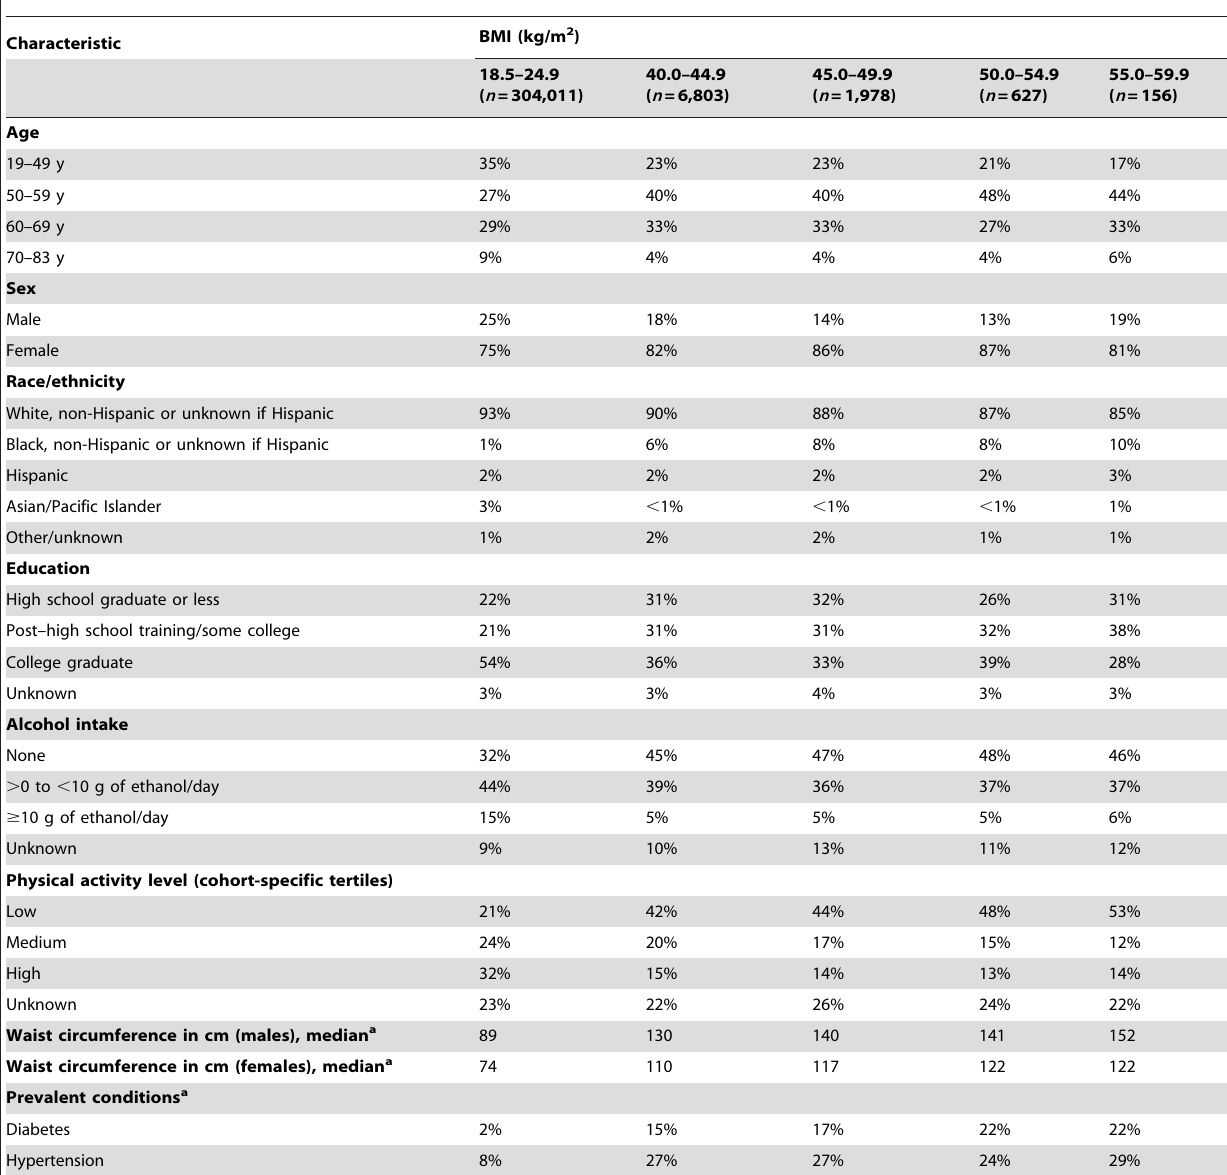
Data are percent, unless otherwise indicated. a Among those without missing values. Proportion missing: waist circumference, 73%; diabetes, 8%; hypertension,